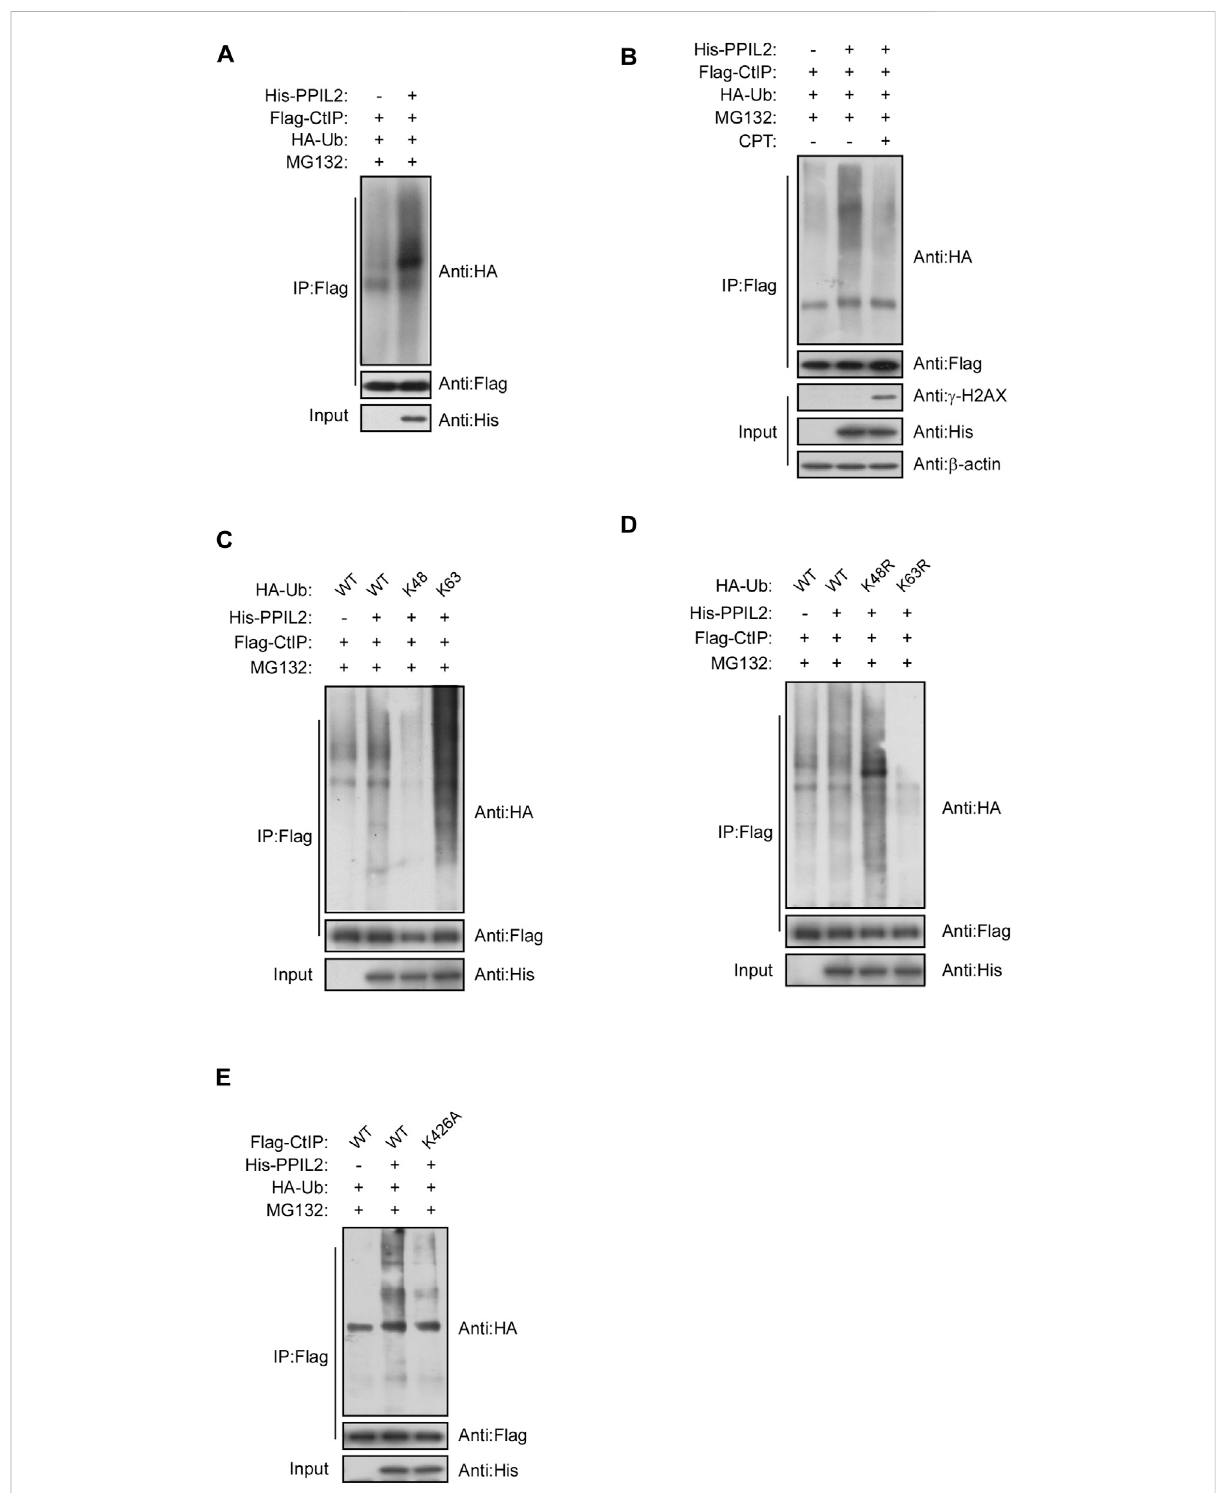
FIGURE 4 PPIL2 ubiquitination of CtIP characterized by co-IP. (A) 293T cells were cotransfected with Flag-CtIP, His-PPIL2, and HA-Ub. 48 h after transfection,thecellsweretreatedwithMG132(20 μ M)for3 h.ThecellswerelysedinNETNbuffercontainingaproteaseinhibitorcocktail(PIC),and the cell lysate was immunoprecipitated with anti-Flag and analysed by immunoblotting with anti-HA. This process was repeated on (B) cells treated for1 hwith 2 μ MCPT; (C) cellscotransfectedwithFlag-CtIP,His-PPIL2 andHA-UbWT,K48orK63; (D) cellscotransfected withFlag-CtIP, His- PPIL2 and HA-Ub WT, K48R or K63R; and (E) cells cotransfected with His-PPIL2, HA-Ub and Flag-CtIP WT or K426A